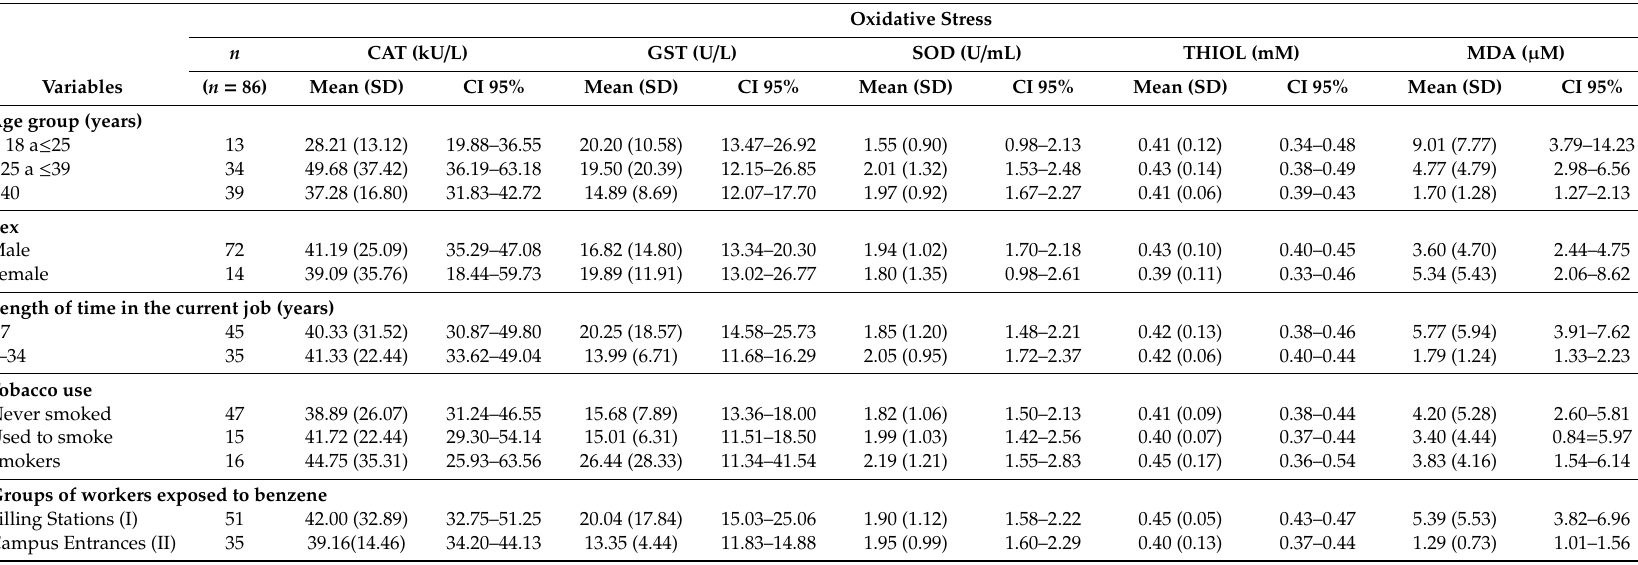
Table 5. Results of the association of biomarkers of oxidative stress, chromosomal aberrations, nuclear abnormalities, and comet assay with FPG per age group, sex, length of time in current job, tobacco use, and exposure